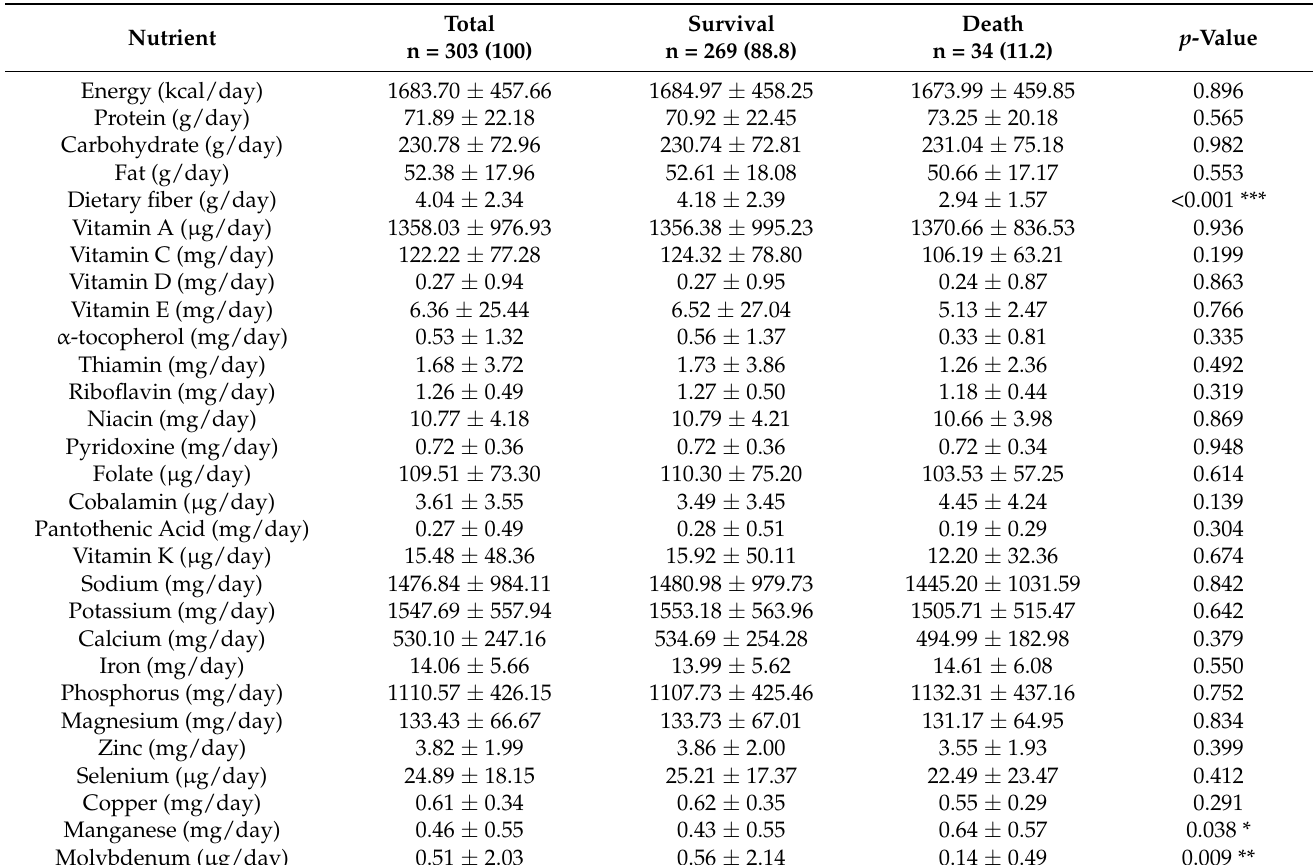
Table 2. The nutrient intake profiles of participants during baseline, total and by mortality status at 5-year follow-up.